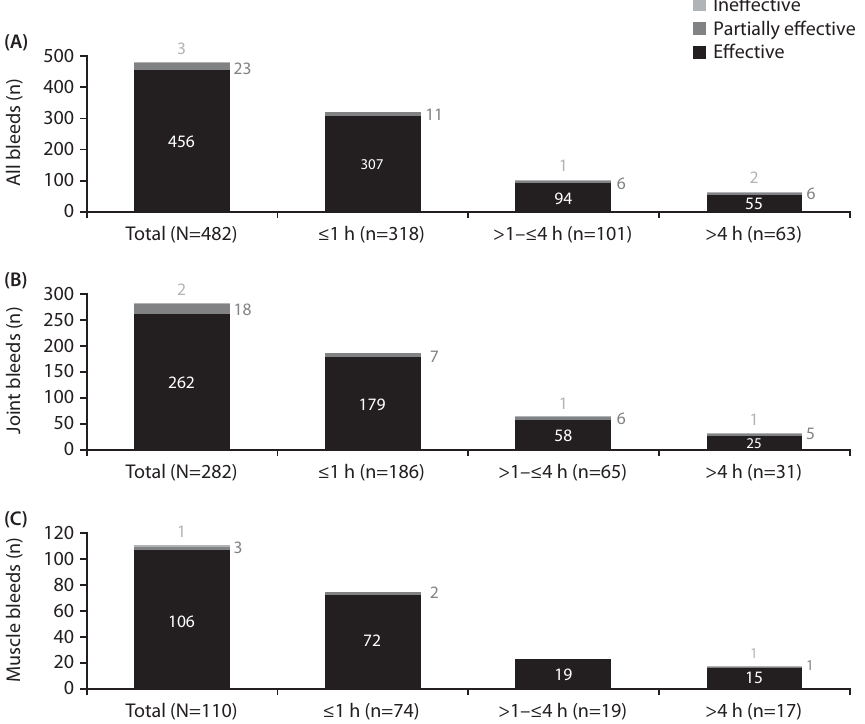
Fig. 2 Hemostatic response with rFVIIa (NovoSeven ® ) monotherapy by time to fi rst treatment in patients with hemophilia A or B and inhibitors in SMART-7 ™ . Bleeding episodes treated with recombinant factor VIIa (rFVIIa) monotherapy and with (1) valid ef fi cacy assessment, (2) no missing time for bleed start, (3) no missing time for any dose administration, and (4) valid time to fi rst treatment were included. TH Open Vol. 1 No.